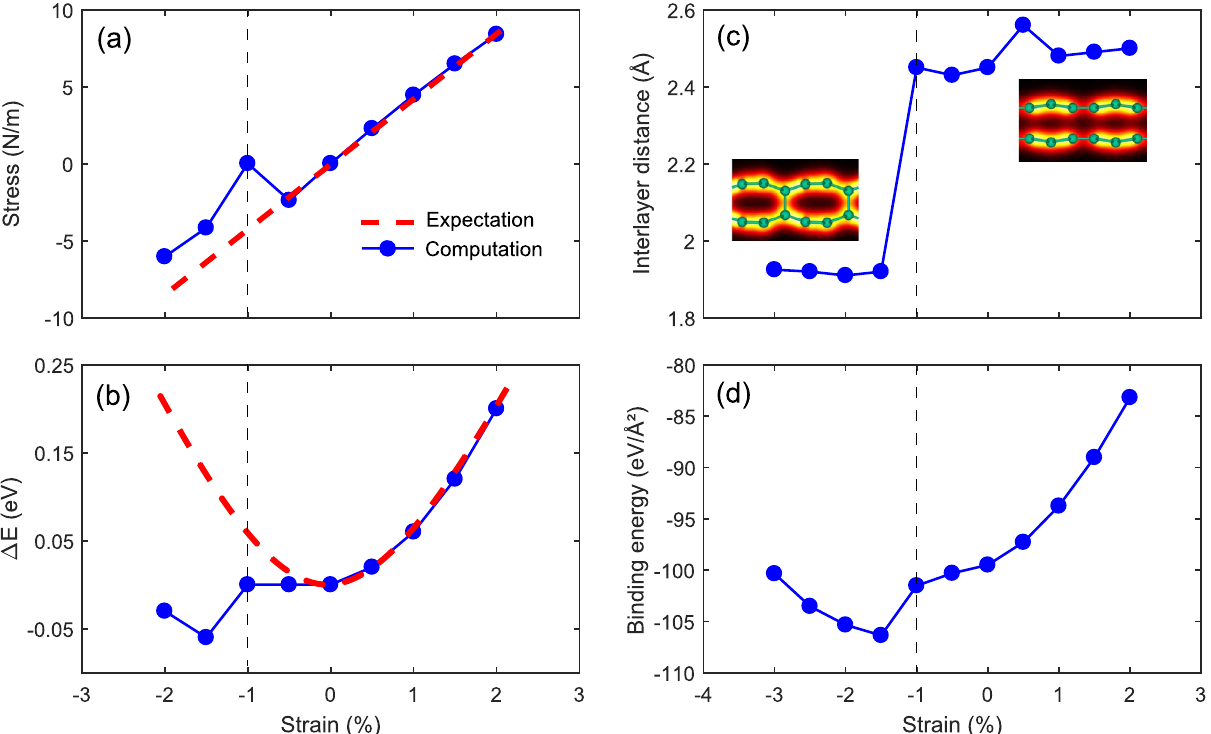
Figure 2. Evaluation of ( a ) stress, ( b ) total energy, ( c ) interlayer distance, and ( d ) binding energy of the relaxed model with the applied strain. The total energy was substituted from the pristine total energy ( (cid:31) E = E − E 0 ). The expected harmonic behavior is shown with red dashed lines in ( a , b